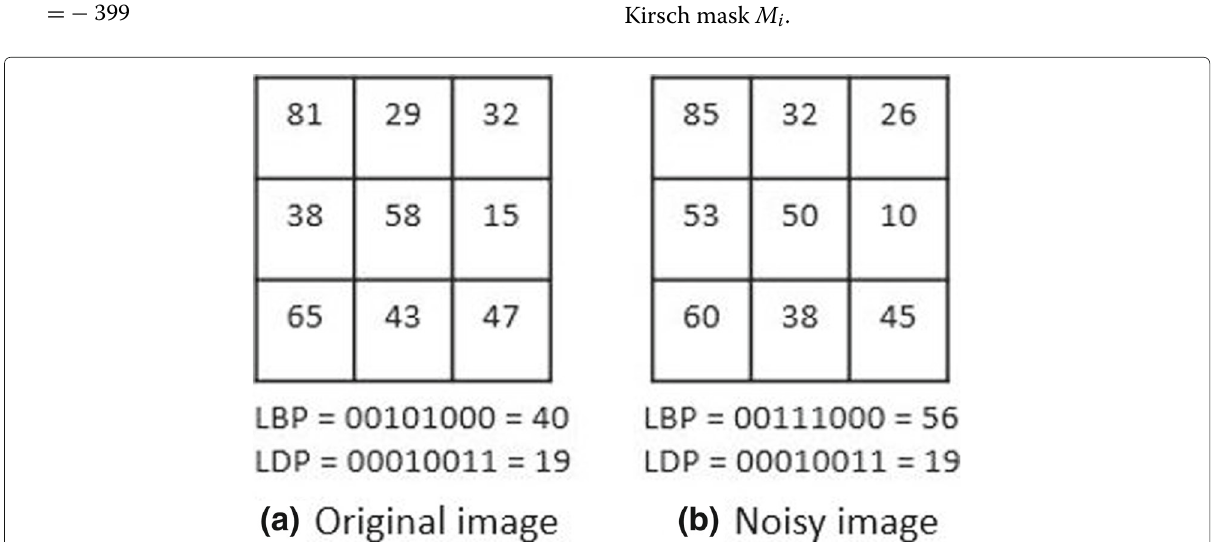
Fig. 10 a , b Robustness of LDP compared to